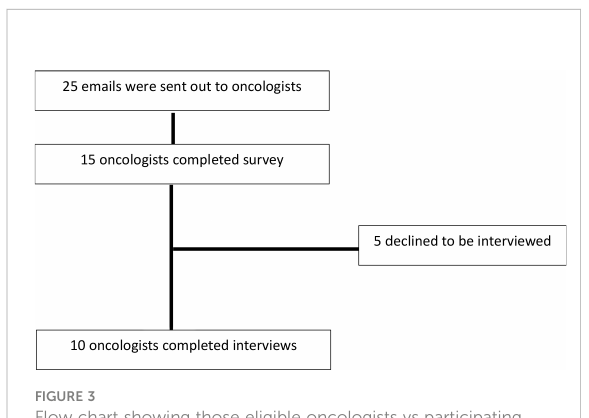
FIGURE 3 Flow chart showing those eligible oncologists vs participating